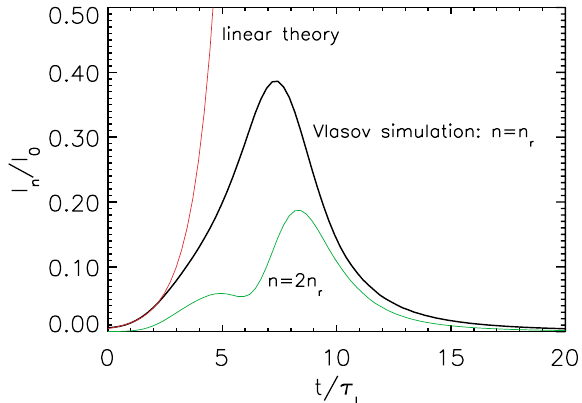
FIG. 6. (Color) Time evolution of the current amplitudes ob- tained from the Vlasov simulation for U sc (cid:2) 10 , V bb (cid:2) 1 , and n r (cid:2) 12 .